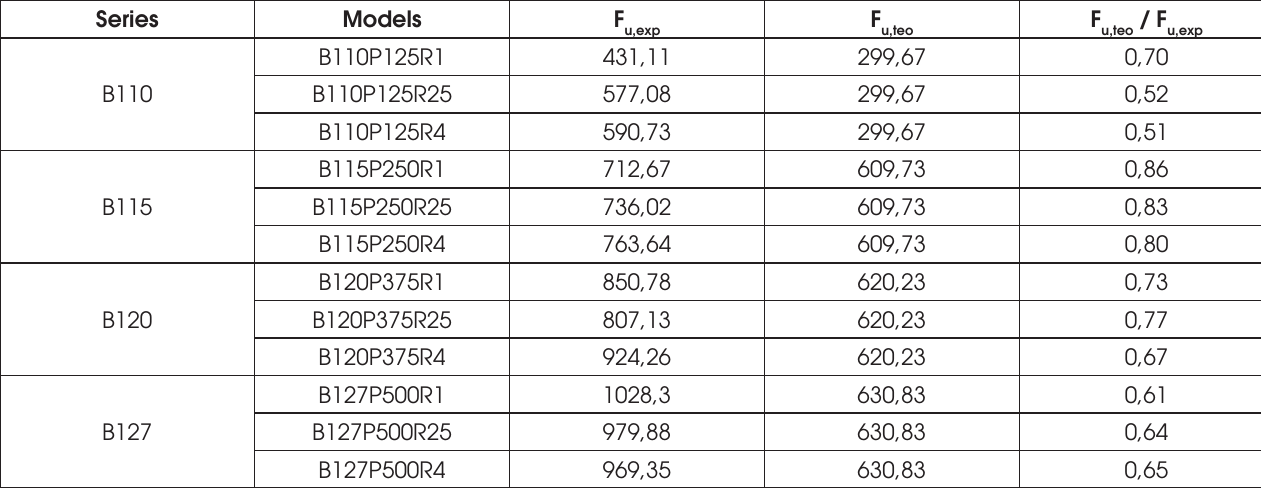
Experimental and theoretical strength